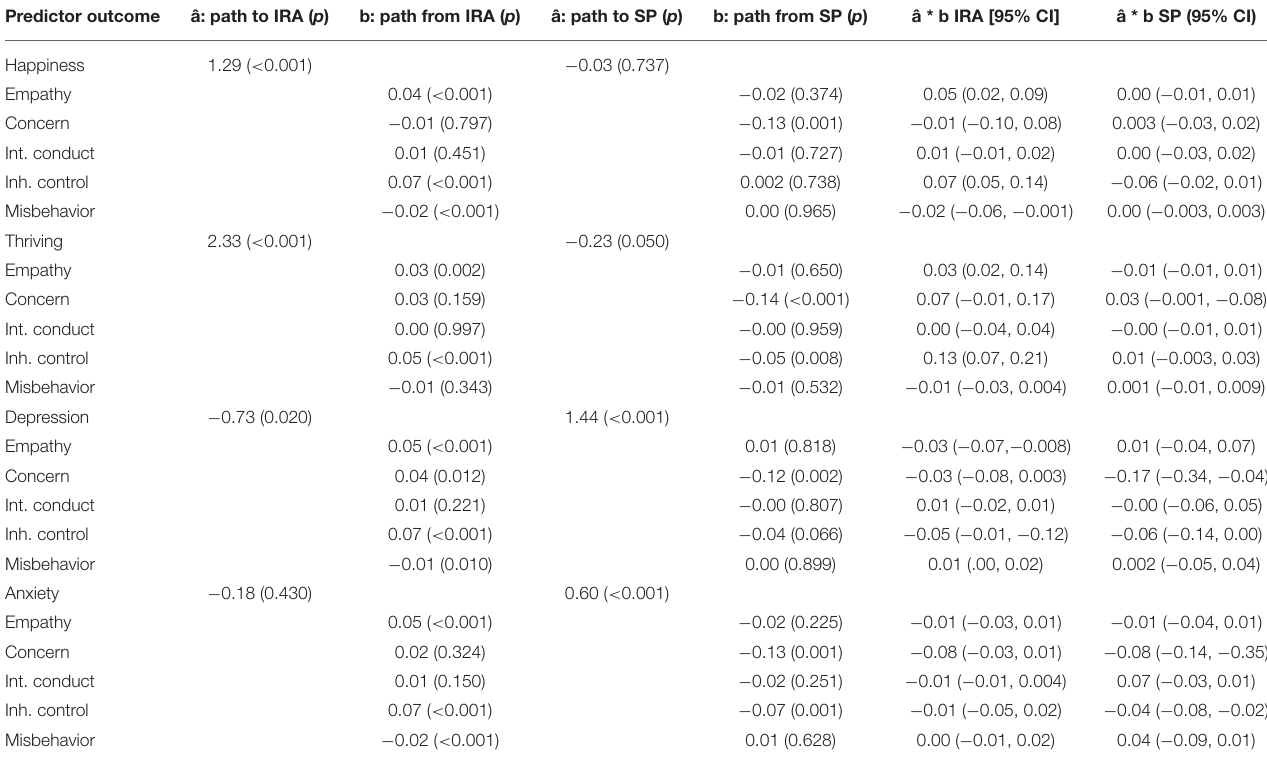
TABLE 6 | Study 2 (China) summary of mediation effects. Predictor